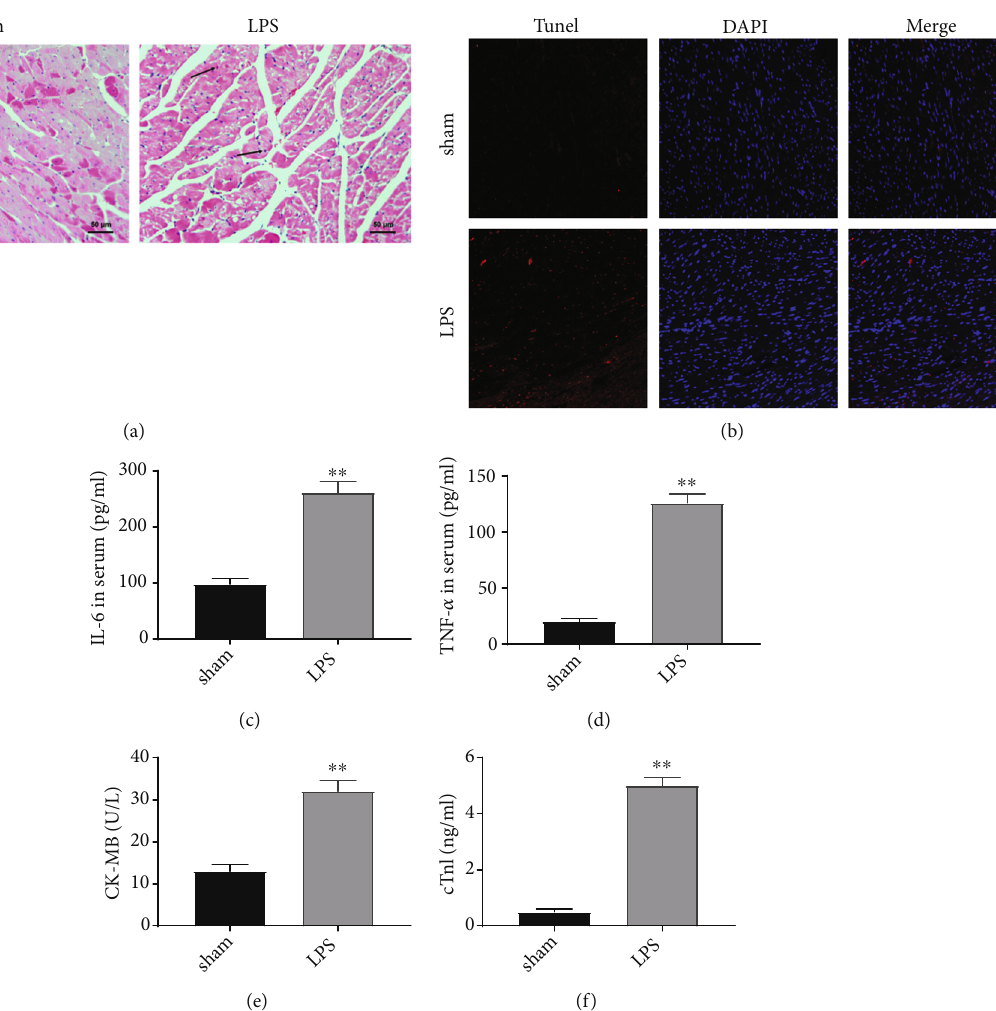
Figure 1: LPS-induced myocardial injury in a rat model. (a) H&E staining showed the pathological changes in the myocardial tissues of LPS-treated rats. Black and white arrows indicate eosinophils and neutrophils, respectively. Scale bar =50 μ m. Magni fi cation: 200 × . (b) TUNEL staining of apoptotic myocardial cells in LPS-treated rats. Magni fi cation: 400 × . The serum levels of IL-6 (c), TNF- α (d), CK-MB (e), and cTnl (f) in LPS-treated rats. ** P < 0 : 01 versus